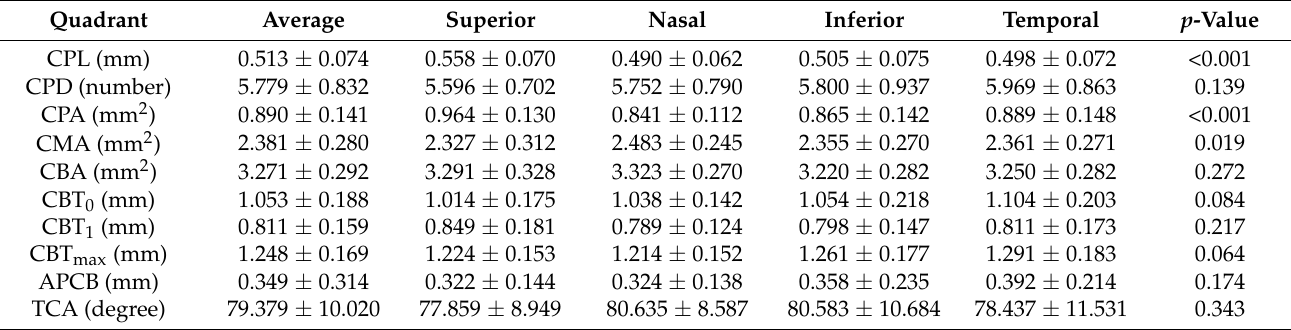
Table 3. Ciliary body and ciliary process parameters measured in the four